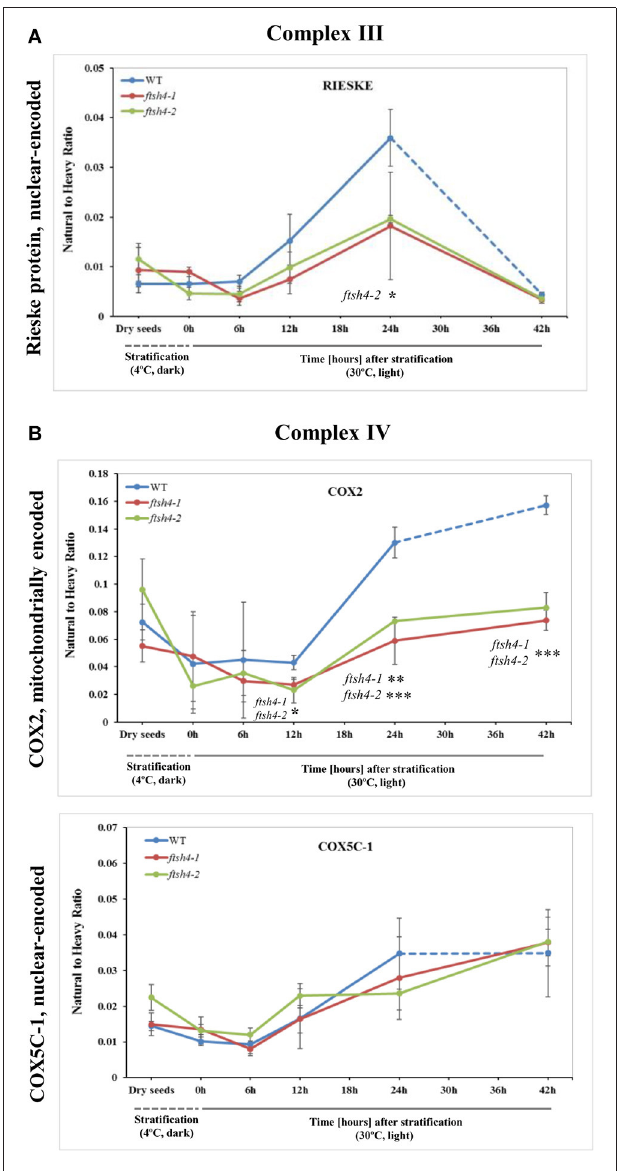
FIGURE 5 | Quantitative time-course profiling of selected complex III (A) and complex IV (B) subunits in ftsh4 mutant seeds in comparison to those of WT during germination estimated by MRM. (A) Data show the abundance of RIESKE protein (At5g13440) determined as the geometric mean of the peptides FVYASVLR and GPAPYNLEVPTYSFLEENK. (B) Data show the abundance of COX2 (AtMg00160) determined as the geometric mean of the peptides LLEVDNR, IIVTSADVLHSWAVPSLGVK and LNQISILVQR as well as COX5C-1 (At2g47380) and the peptide TFYDLLERCOX2. Other descriptions are the same as in Figure 4 . Data are mean ± SD of three independent biological replicates. * p ≤ 0.05; ** p ≤ 0.01; *** p ≤